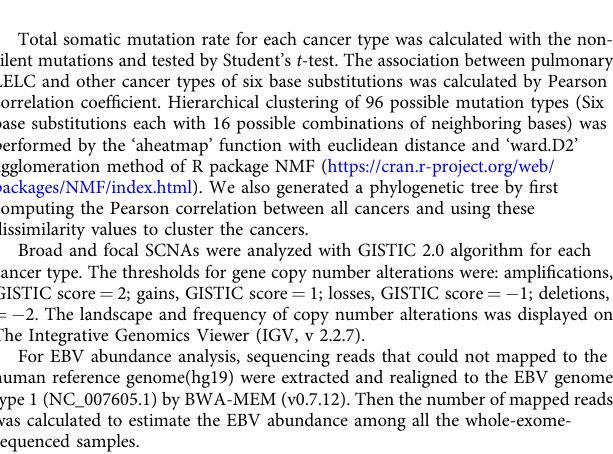
Fig. 7a. And a customized DNA enrichment kit, capturing all exons from these 114 genes and targeting ~700k genomic regions, was designed. Genomic DNA